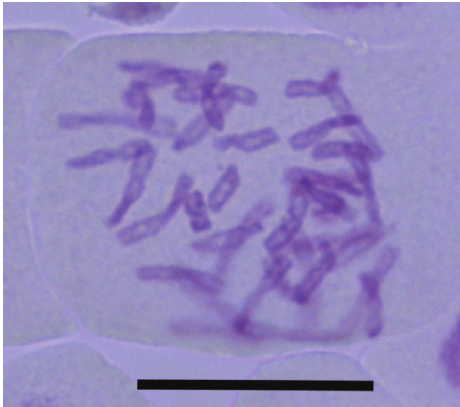
Figure 10. Anthemis cretica L. subsp. petraea (Ten.) Oberpr. & Greuter, 2 n = 36. Scale bar: 10 μm. Anthemis cretica L. subsp. petraea (Ten.) Oberpr. & Greuter (Asteraceae) Chromosome number: 2 n = 36 (Fig.